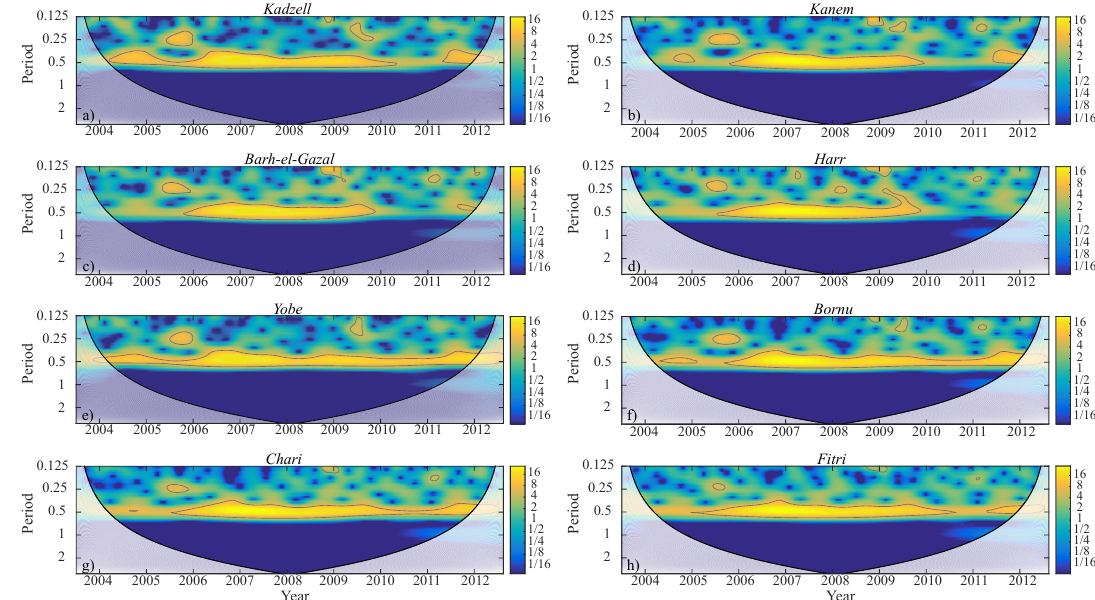
Figure 4. Same as Figure 3 except that the annual cycle have been removed from the GRACE signal by subtracting the inverse Fourier transform of longer periods.